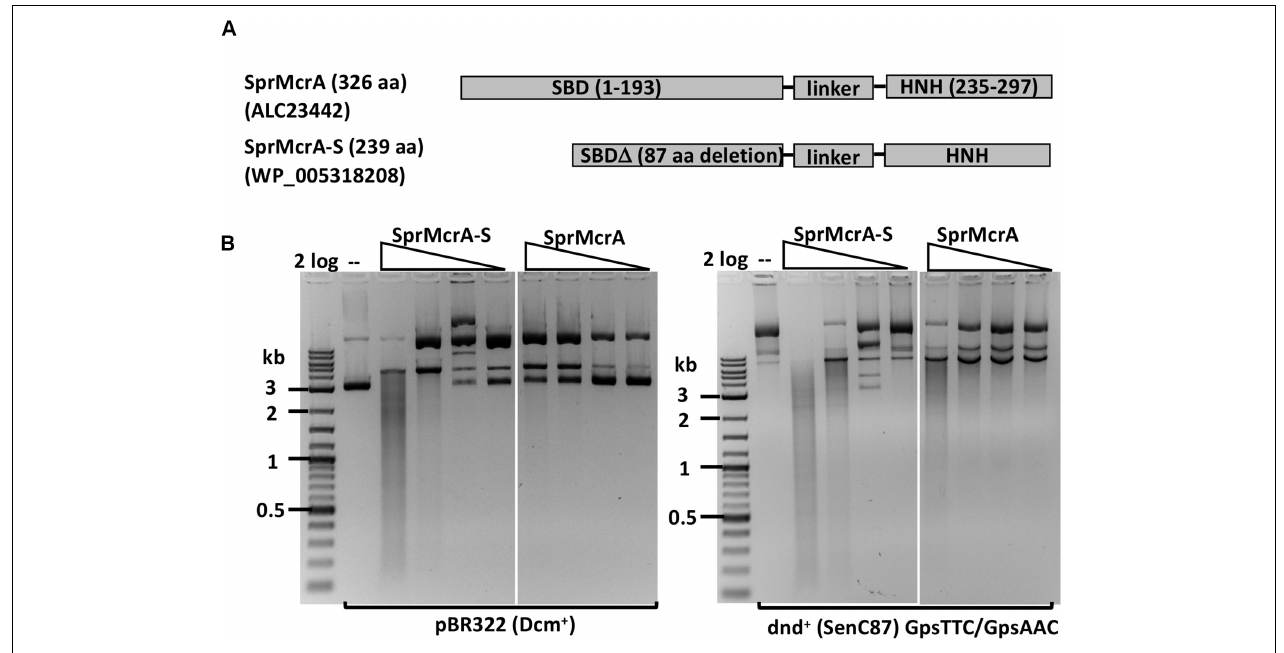
FIGURE 2 | SprMcrA and SprMcrA-S (S for short truncated form) domain organization and activity assays. (A) Schematic diagram of SprMcrA and SprMcrA-S (SBD, linker region and HNH). (B) SprMcrA-S and SprMcrA digestion of pBR322 and dnd + plasmids (SenC87) in Mn 2 +